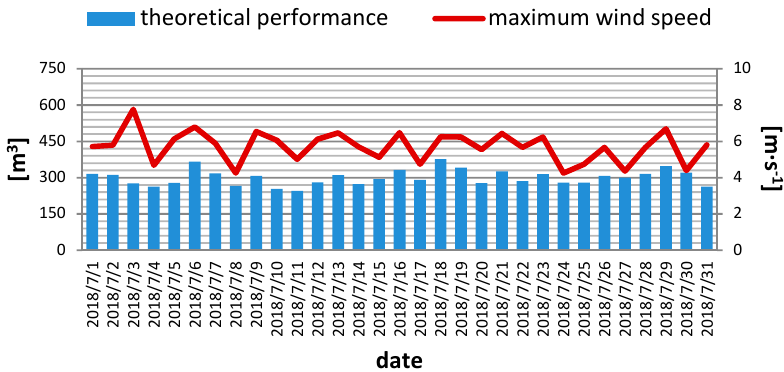
Figure 7. E ffi ciency of the pulverization unit of the aerator in June. Figure 7. Efficiency of the pulverization unit of the aerator in June.